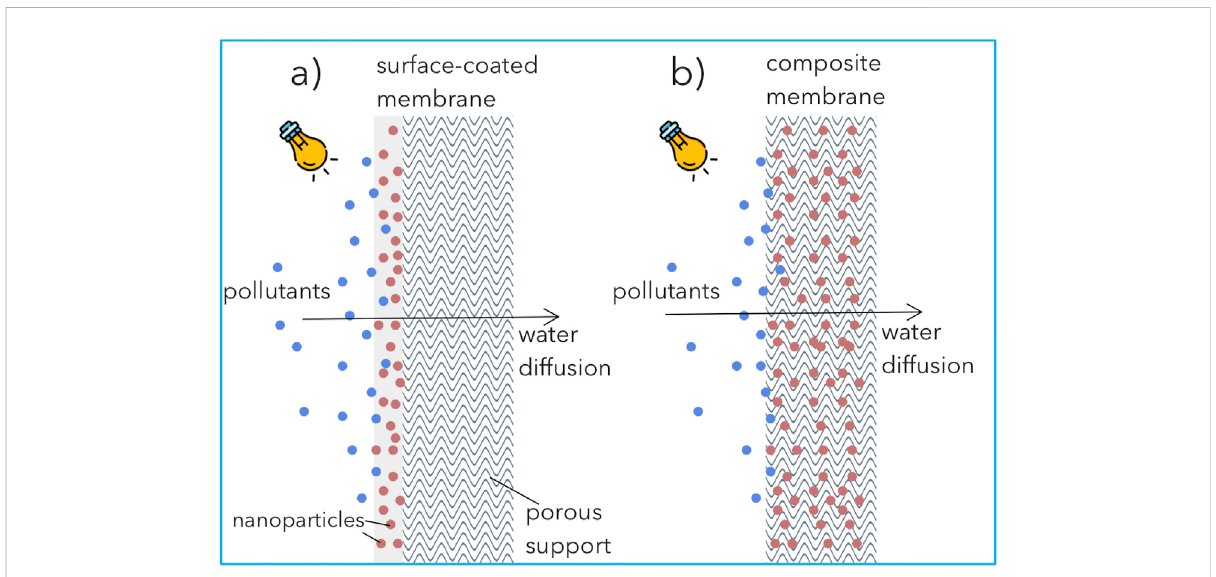
FIGURE 6 Schematicrepresentationofnanoparticlesimmobilizedin/oncompositemembranes: (A) surface-coatedmembrane; (B) nanoparticlesmatrix- blended